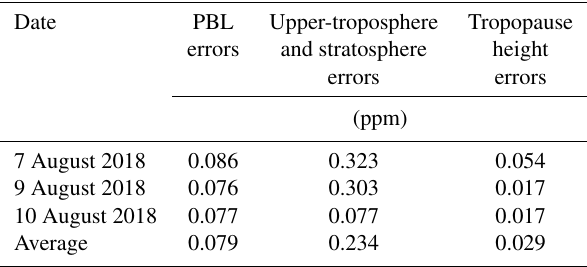
Figure 7. Extrapolated CO 2 profiles observed on 7, 9 and 10 August 2018, over Jiansanjiang by method (2). Red, blue and yellow solid lines show the aircraft-based (in situ) data collected on 7, 9 and 10 August, respectively, averaged for each flat stage of the flight. Dotted lines show the extrapolated parts of the profiles, with colors corresponding to sampling dates in accordance with the solid lines. Black horizontal lines show the tropopause height from NCEP re- analysis data. Table 4. Aircraft integration error budget of X CO estimation for 2 method (2). Errors in the three profiles from multiple error sources contributed to the calculation results of the integrated total column. There are four sources of error, similar to previously described er- ror budgets (Wunch et al., 2017): the contribution from the aircraft profile itself, the contribution from the unknown surface to the bot- tom of the profile, the contribution from the upper troposphere and stratosphere, and error from the tropopause